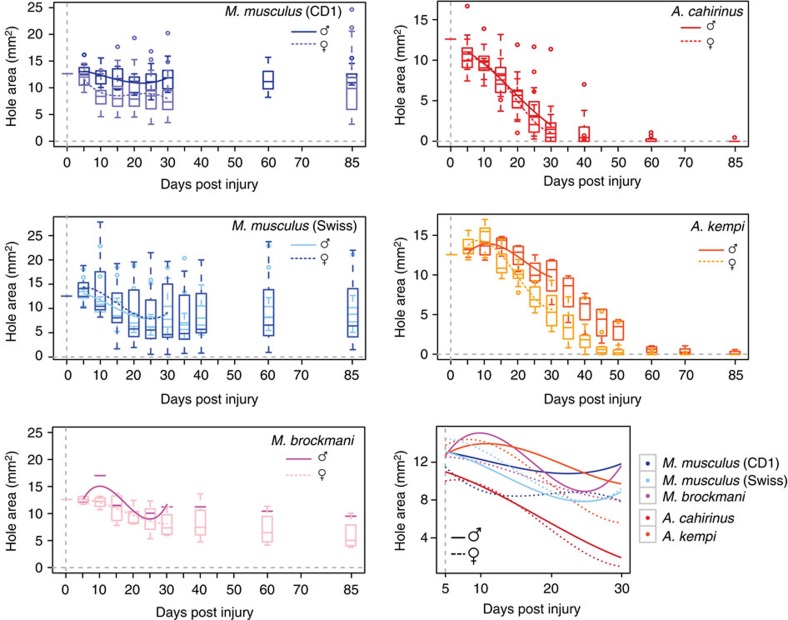
A cubic function describes ear closure across species.Ear-hole area modelled over time following a 4-mm ear-hole punch for each species (box and whiskers). The estimated cubic function is overlaid from D5–D30, and the data are graphed separately for each sex (male=solid line and female=dashed line). For comparison, all cubic functions are overlaid in bottom right panel.